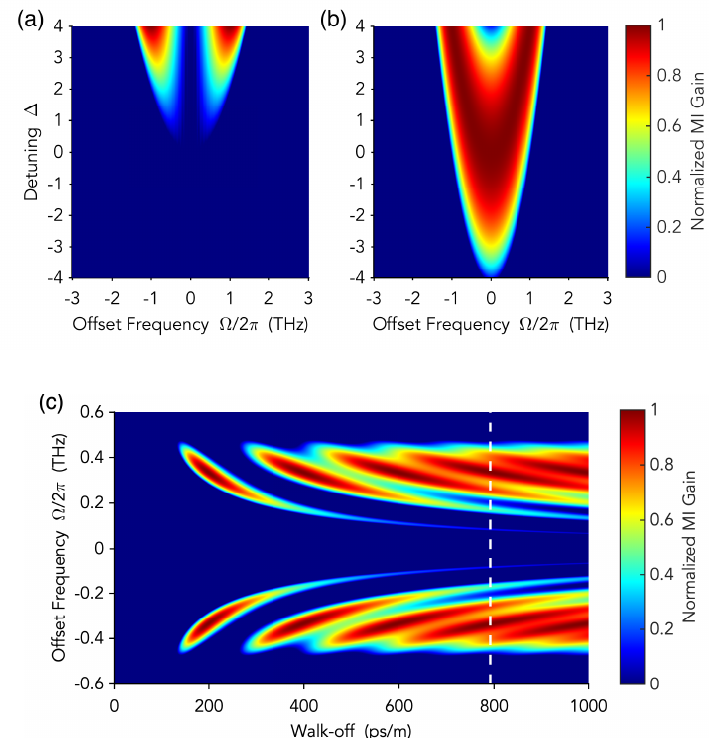
Figure 6. Optical frequency combs (OFC) in a degenerate OPO. ( a , b ) show the MI gain as a function of the normalized cavity detuning ∆ = δ 1 / α 1 , for the constant solution and the zero solution, respectively. ( c ) MI gain profiles as a function of the temporal walk-off. Adapted with permission from [54]. Copyrighted by the American Physical